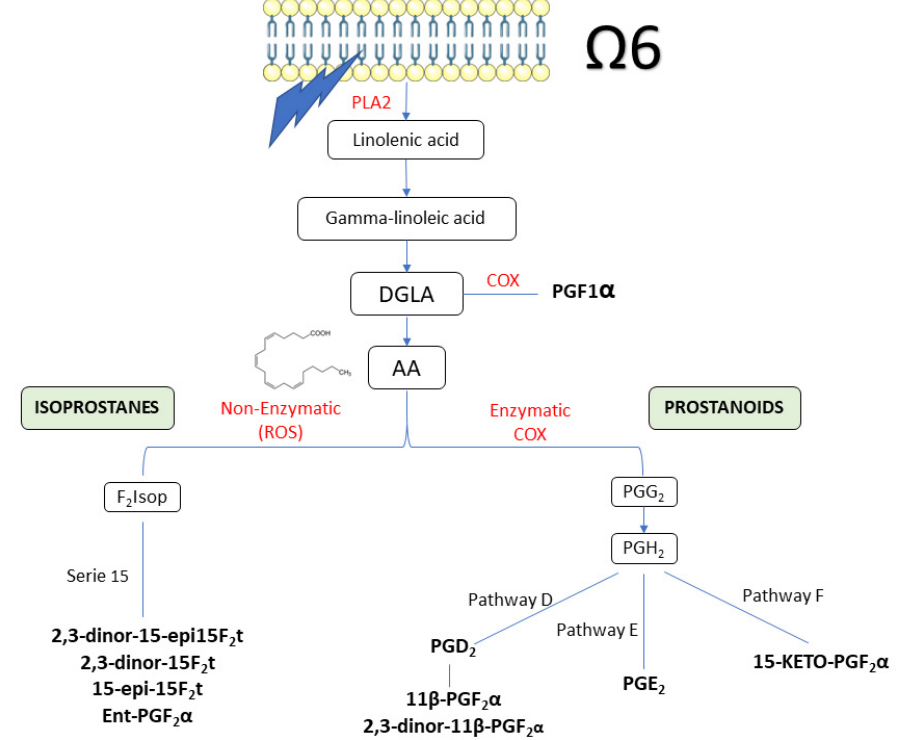
Figure 3. Summary of the pathway of oxylipins quantified in the current study. Oxylipins are in bold. AA: arachidonic acid; DGLA: dihomo- γ -linoleic acid; PLA2: Phospholipase Table 3. Evolution of the different isoprostanes measured during the study. Values are expressed as mean and standard deviation at the beginning and end of the intervention.